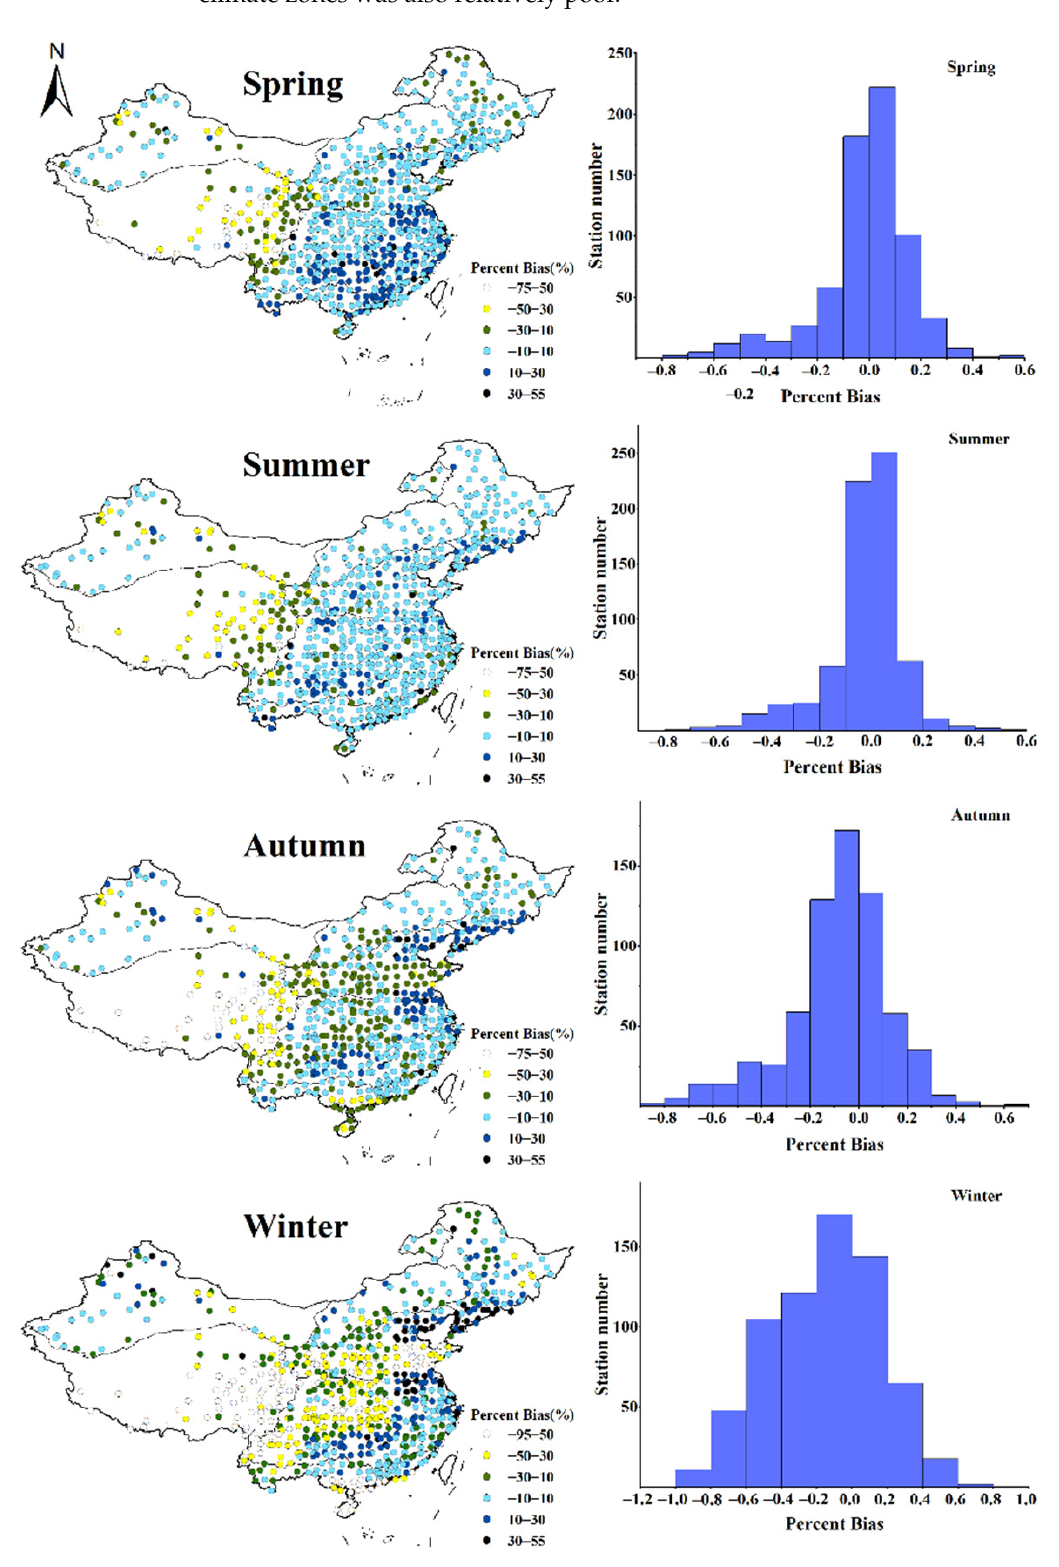
Figure 9. Seasonal PBias of ET 0 calculated from CLDAS dataset.